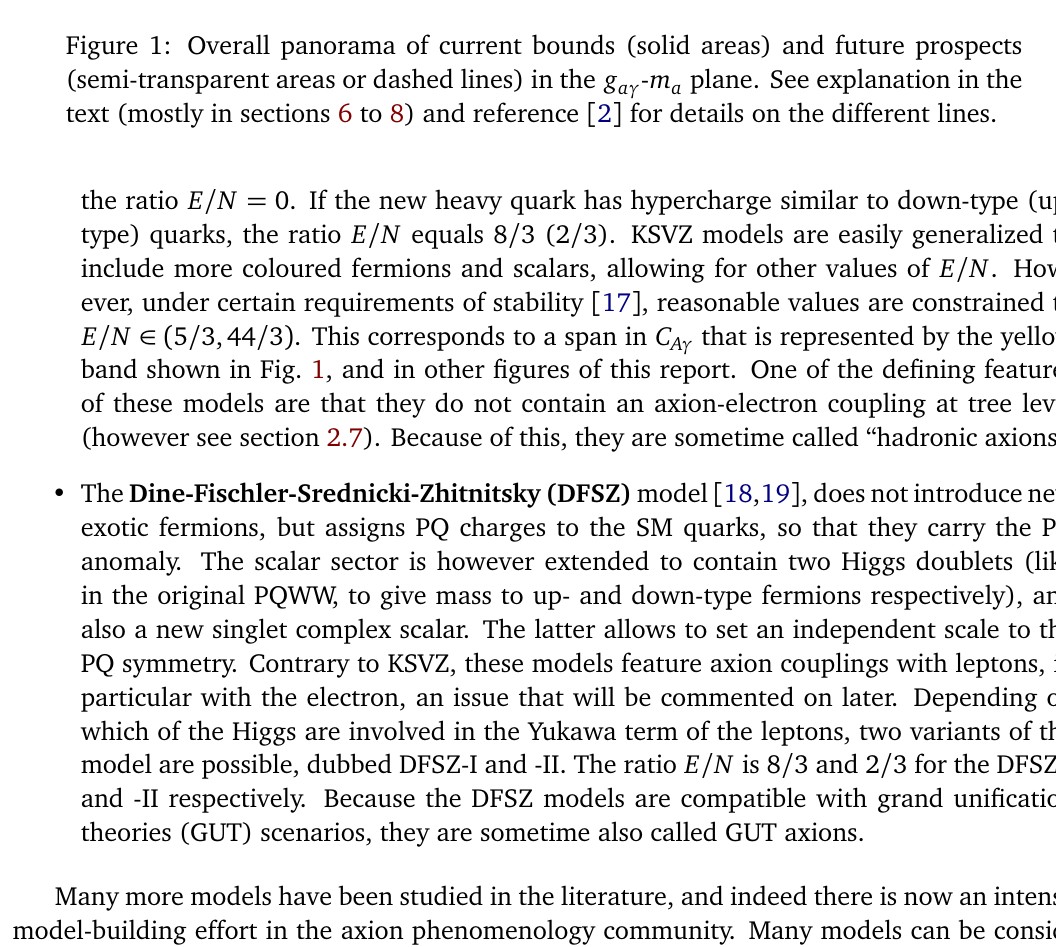
- m plane. See explanation in the a γ a